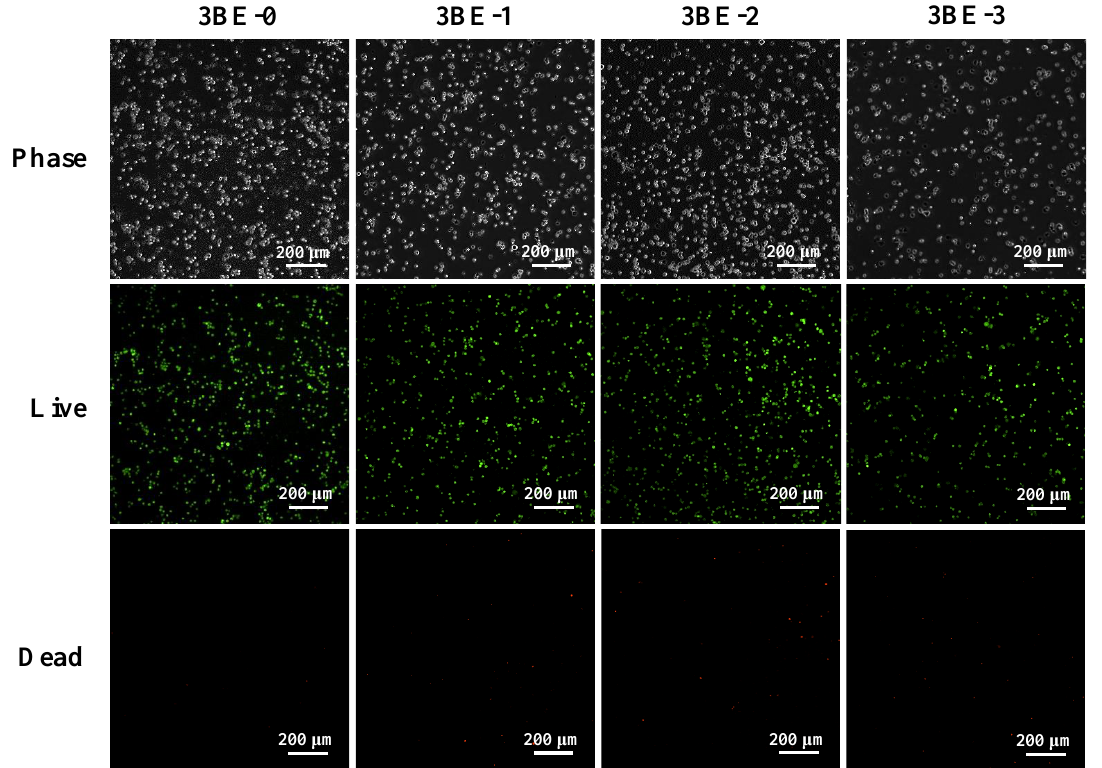
Figure 4. Live/dead analysis of cell viability in different concentrations of the 3BE before bioprinting. The green color indicates cells live and the red color indicates cells dead.